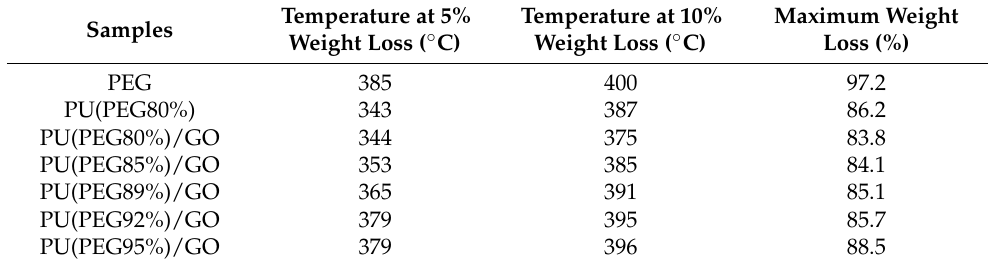
Figure 6. TG curves of PEG, PU and PU/GO. Table 4. TG data of PU and PU/GO in nitrogen.